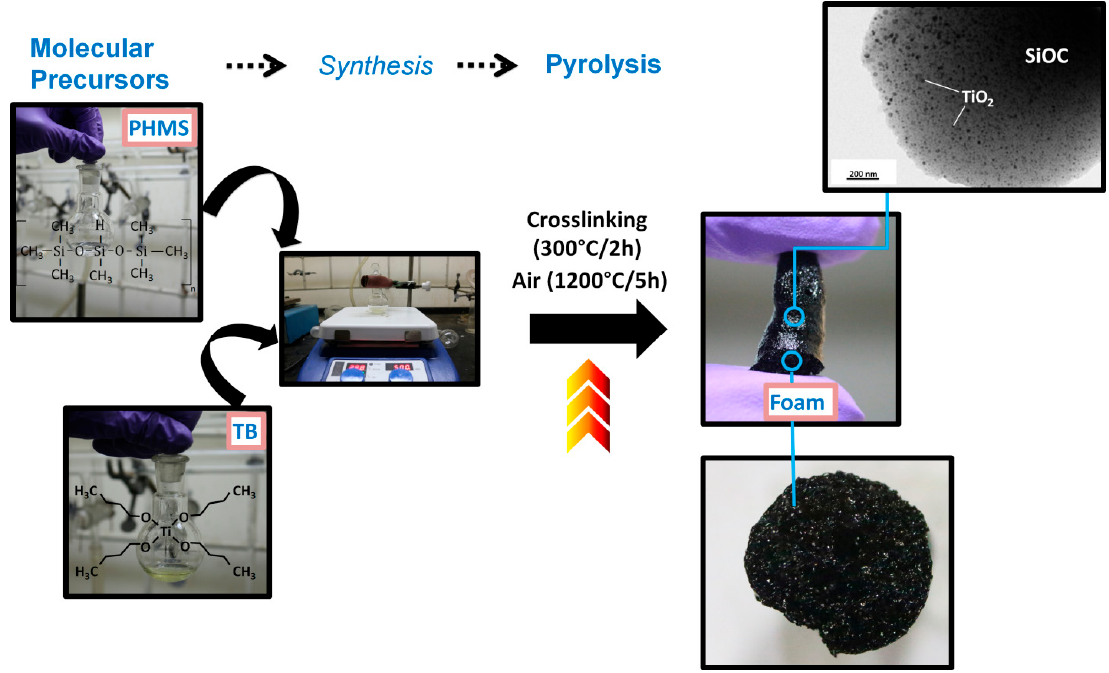
Figure 1. Schematic diagram of the general process for the synthesis of macroporous TiO 2 /SiOC